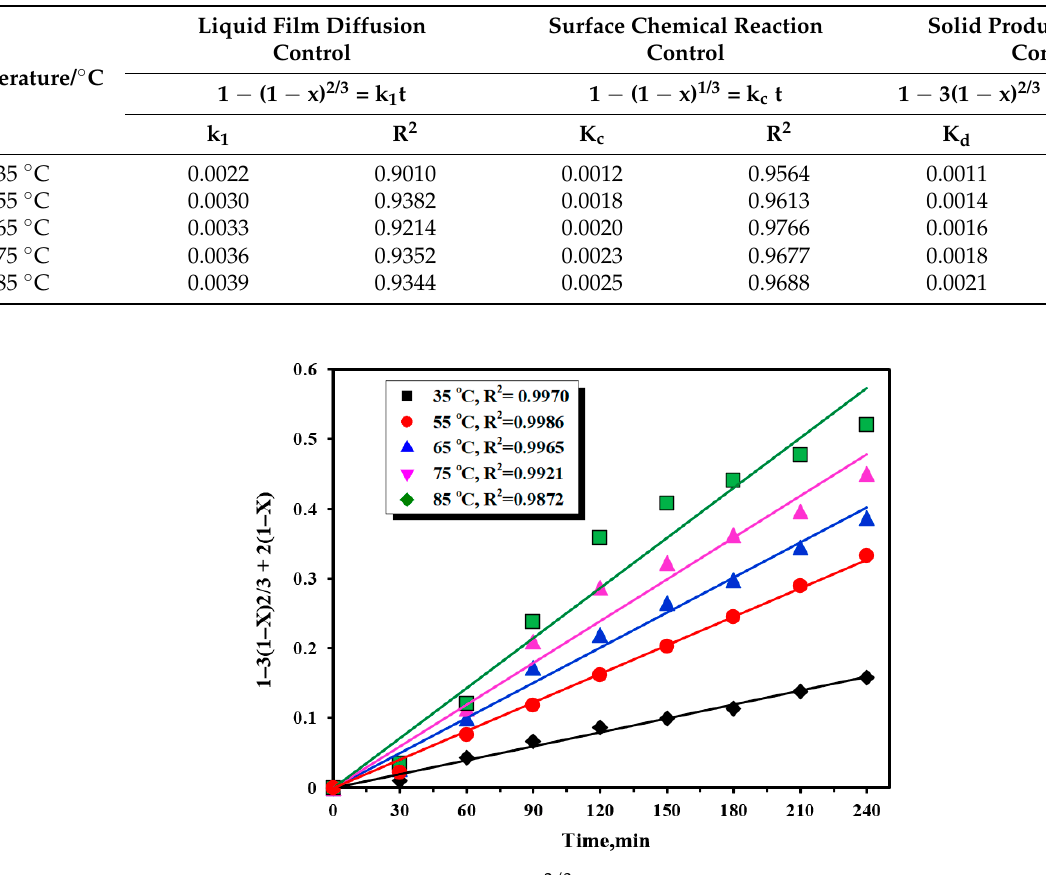
Table 7. Zinc leaching kinetics parameters of different models during the reaction time.